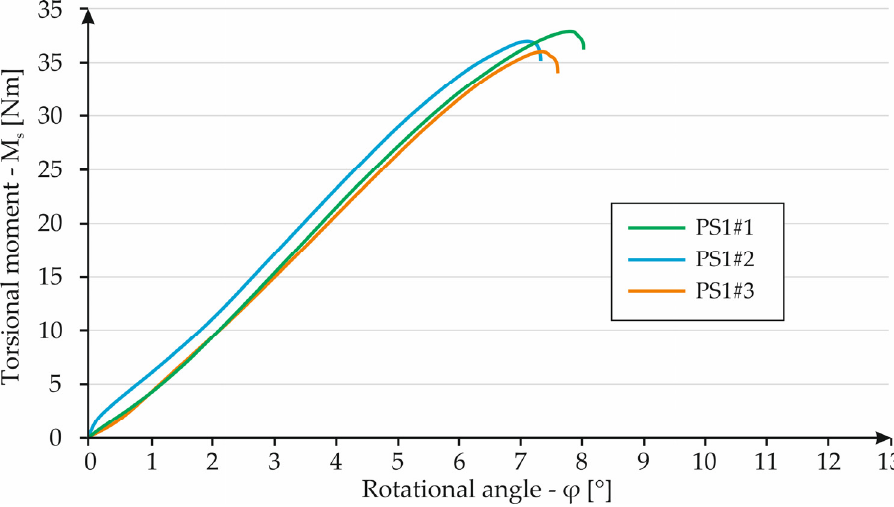
Figure 16. Graph showing the dependence of torque on torsion angle for PS1 specimens.